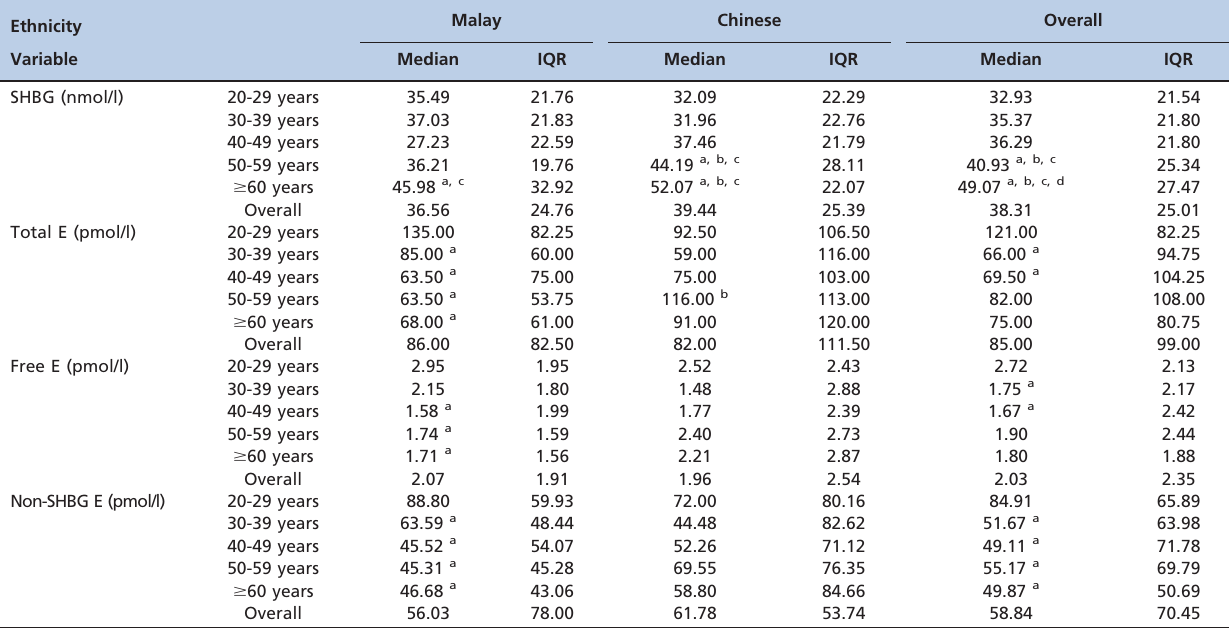
Table 4 - SHBG and estradiol levels between the ethnic groups.